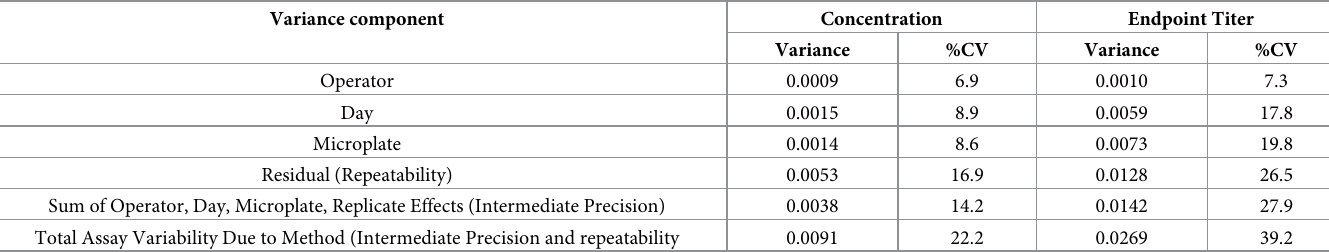
Table 5. Repeatability and intermediate precision